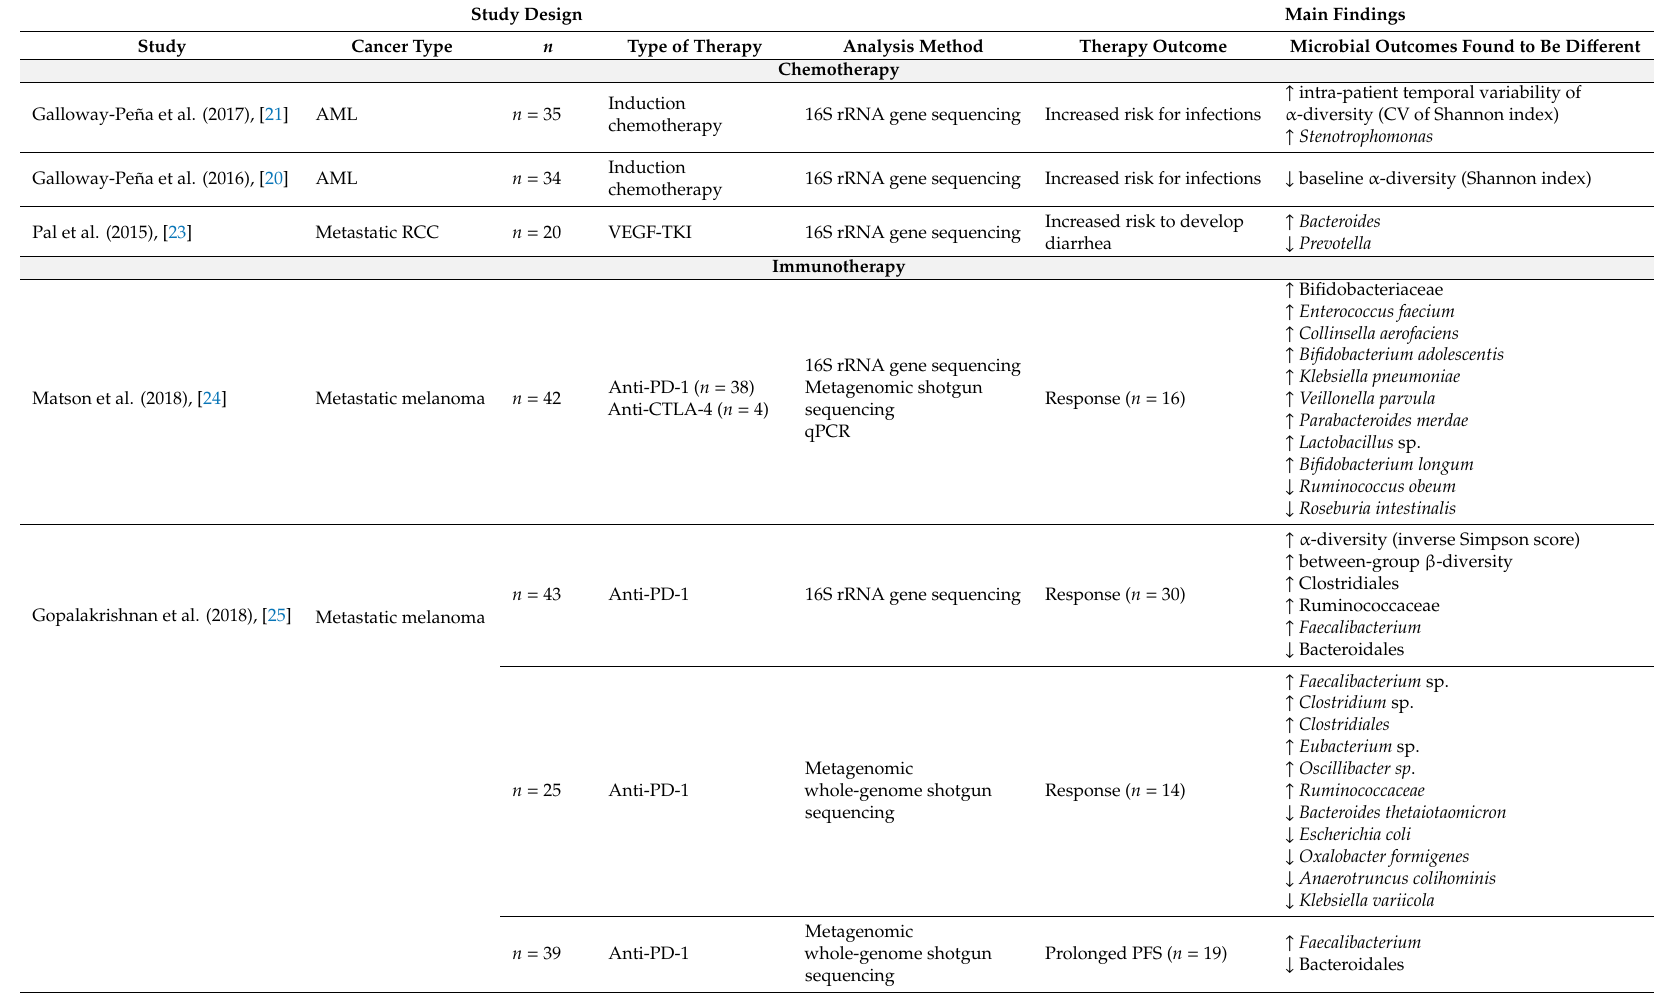
Table 1. Clinical studies investigating the association between baseline intestinal microbiota composition and systemic cancer therapy outcome and